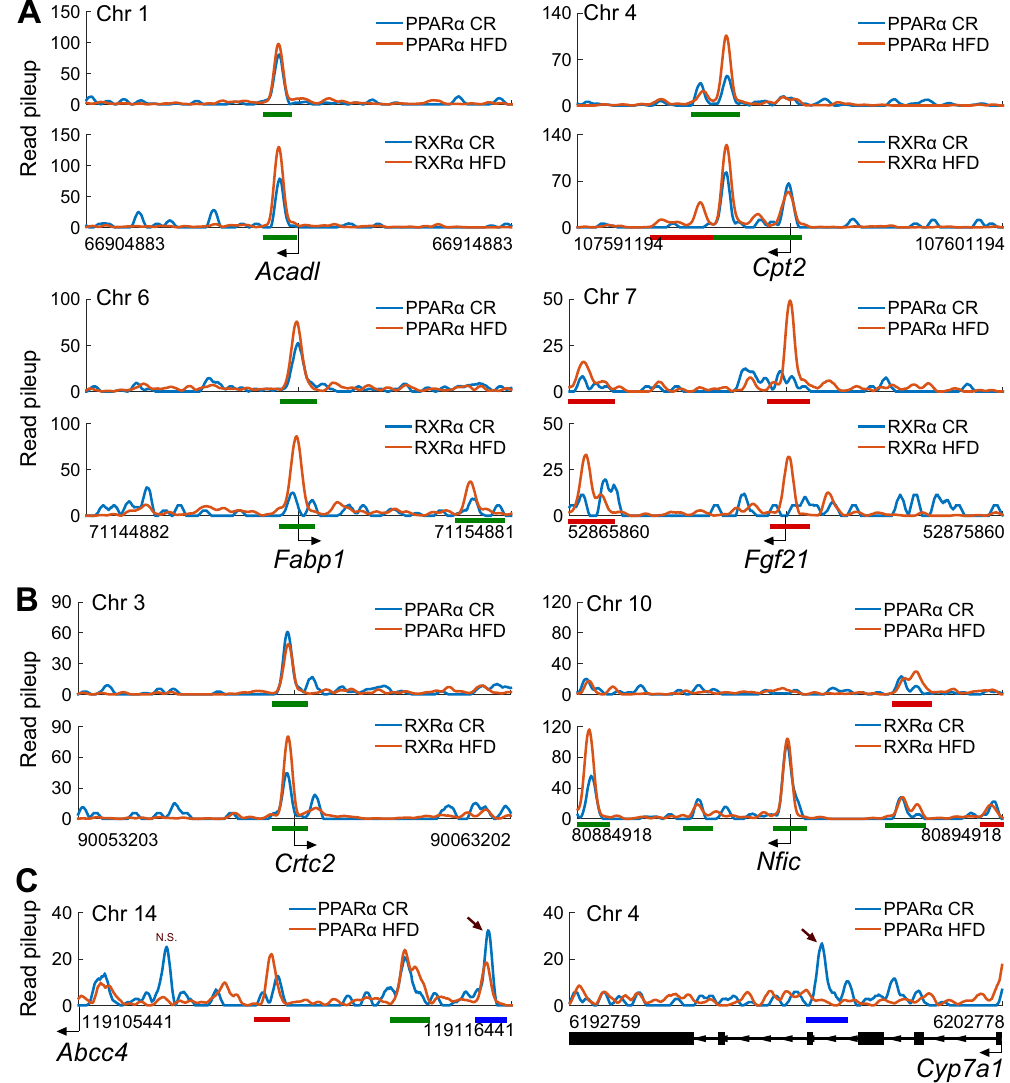
Figure 3. ChIP-Seq of PPAR α and RXR α transcription factors in CR and HFD livers reveals extensive binding near known and novel regulated genes. ( A ) The binding profiles ( + / − 5 kb gene TSS) for known PPAR α and RXR α targets Acadl , Cpt2 , Fabp1 , and Fgf21 in CR and HFD livers are shown. ( B ) The binding profiles ( + / − 5 kb gene TSS) for novel PPAR α and RXR α targets Crtc2 and Nfic in CR and HFD livers are shown. ( C ) The binding profiles for PPAR α near the differentially expressed genes Abcc4 and Cyp7a1 (CR vs. HFD) that contain differential binding events between the same two diets in our ChIP-Seq data. Arrows indicate differential binding regions; N.S. stands for not significant. Read pileup refers to extended, normalized, and smoothed read pileup counts extracted from concatenated pools of aligned reads for the biological replicates for each factor (see Methods). Green lines indicate significantly called peaks in both CR and HFD. Red and blue lines indicate significantly called peaks in HFD and CR,